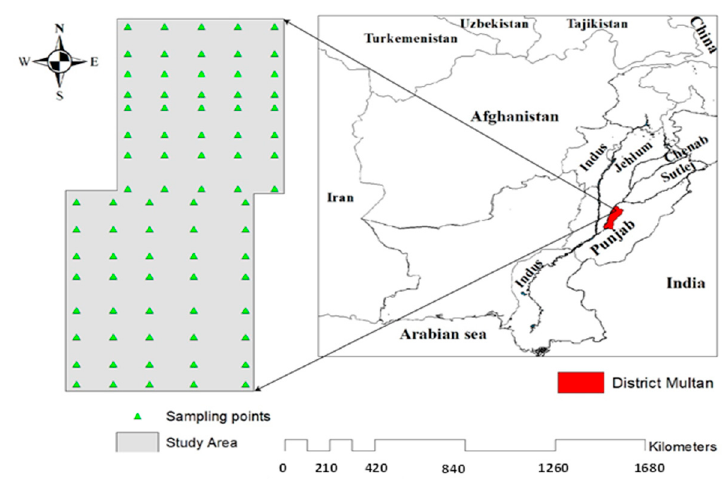
Figure 1. Location of the study area with a sampling position .